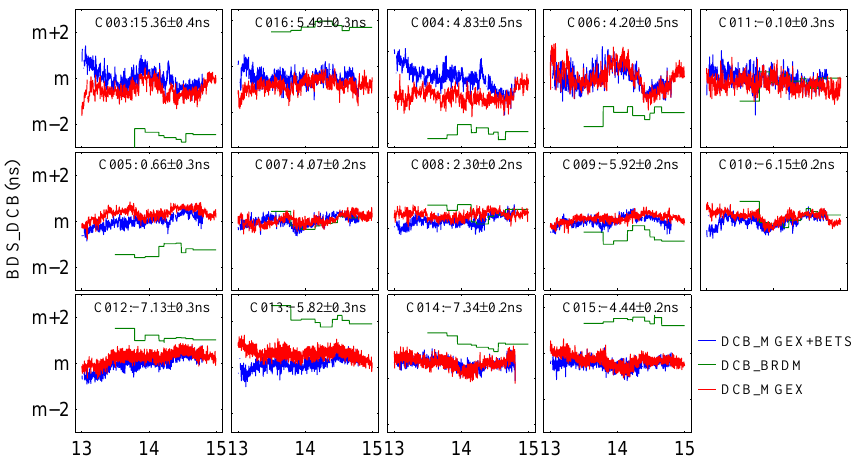
Figure 4. DCB (C2I–C7I) variations in BDS satellites during 2013–2014. The blue, cyan, and red lines are the DCBs estimated from BETS and MGEX BDS data, derived from broadcast navigation messages and provided by the MGEX website, respectively. Here “m” in the vertical axis is the 2-year mean value of corresponding satellite DCBs, while the 2-year mean value and root mean square (RMS) (DCB_MGEX + BETS) are marked for each satellite. The horizontal axis ticks 13, 14, and 15 corresponding to 2013, 2014, and 2015.